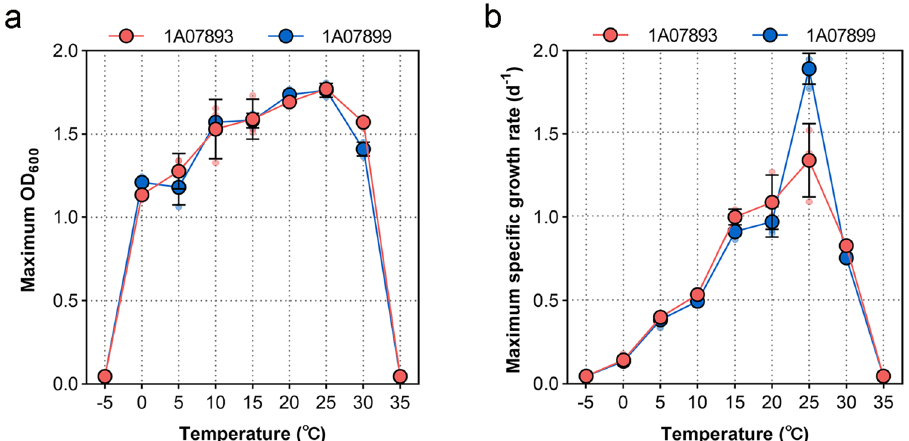
Fig. 1 Growth of L. salsilacus at different temperatures. a Maximum growth biomass represented by OD 600 of L. salsilacus 1A07893 and 1A07899 at temperatures ranging from − 5 to 35 °C. b Maximum growth rates of 1A07893 and 1A07899 at temperatures ranging from − 5 to 35 °C. Strains were grown in marine broth 2216 in triplicate. The error bars represent the standard deviation of three replicates.